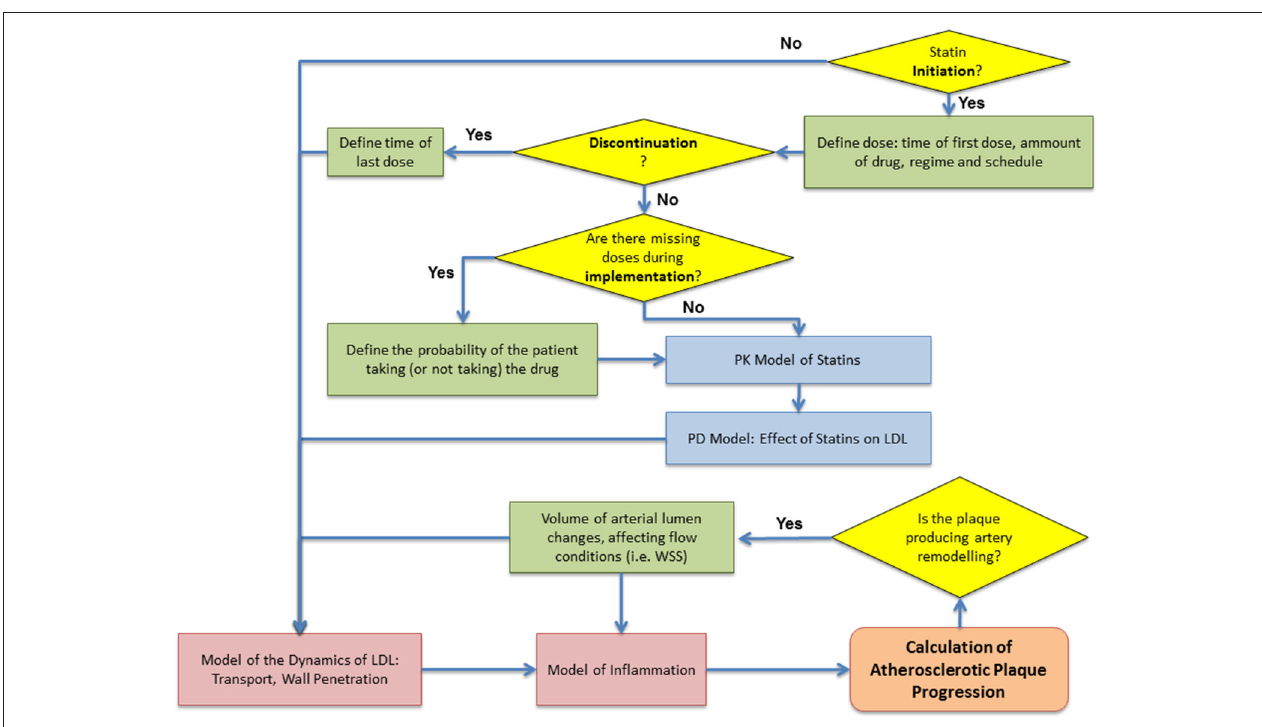
FIGURE 7 | Flowchart of the computational algorithm used to simulate the multiscale model. Patient adherence: initiation, implementation and discontinuation defined as proposed by Vrijens et al. (2012).